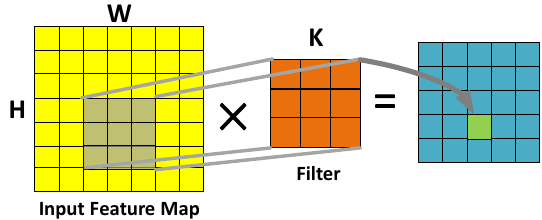
Figure 1. Calculation process of conventional convolutions.